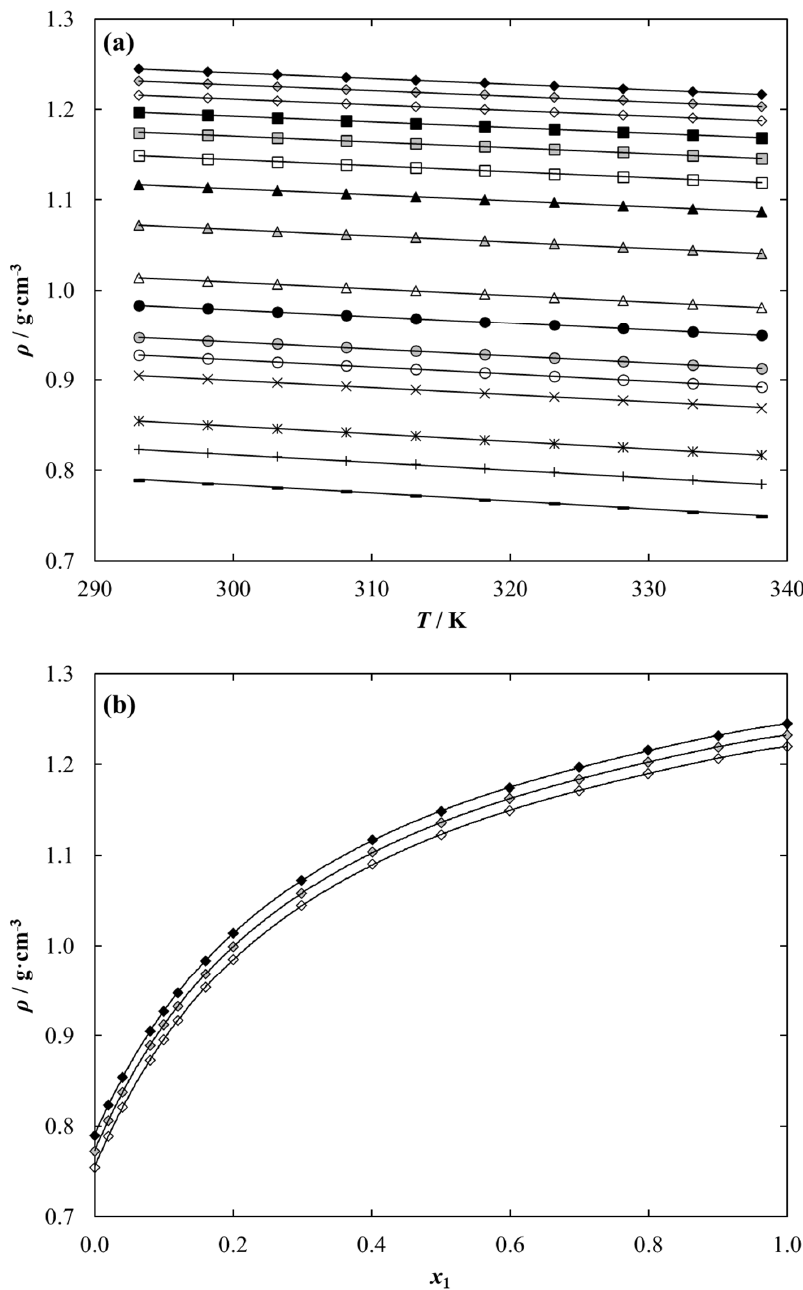
Figure 4. Temperature and composition dependence of liquid density data for {[C 1 C 2 MOR][DMP] (1) + Ethanol (2)} system as a function of ( a ) temperature for different composition, x 1 : ♦ , 1.0000; ♦ ,